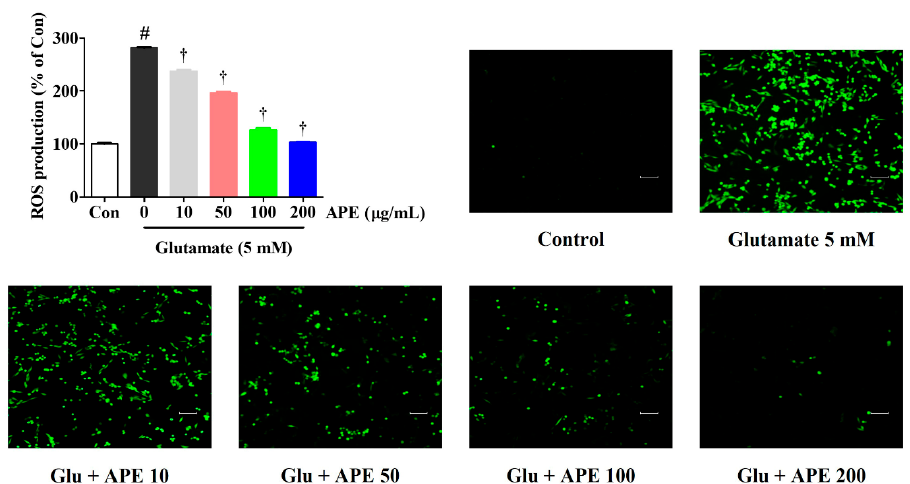
Figure 2. Effects of Arecae Pericarpium ethanol extract on glutamate-induced intracellular ROS production in HT22 cells. Cells were pretreated with APE at concentrations of 10, 50, 100, or 200 µ g/mL and then with 5 mM glutamate. H 2 DCFDA (20 µ M), an oxidation-sensitive fluorescent dye, was used to assess ROS levels. The expression of ROS was determined using a fluorescence microscope and fluorescence microplate reader. Scale bar = 100 µ m. Control was non-treated cells. All experiments were repeated at least three times, and similar results were obtained. Data were presented as mean ± standard error of the mean. Statistical significance was set at # p <